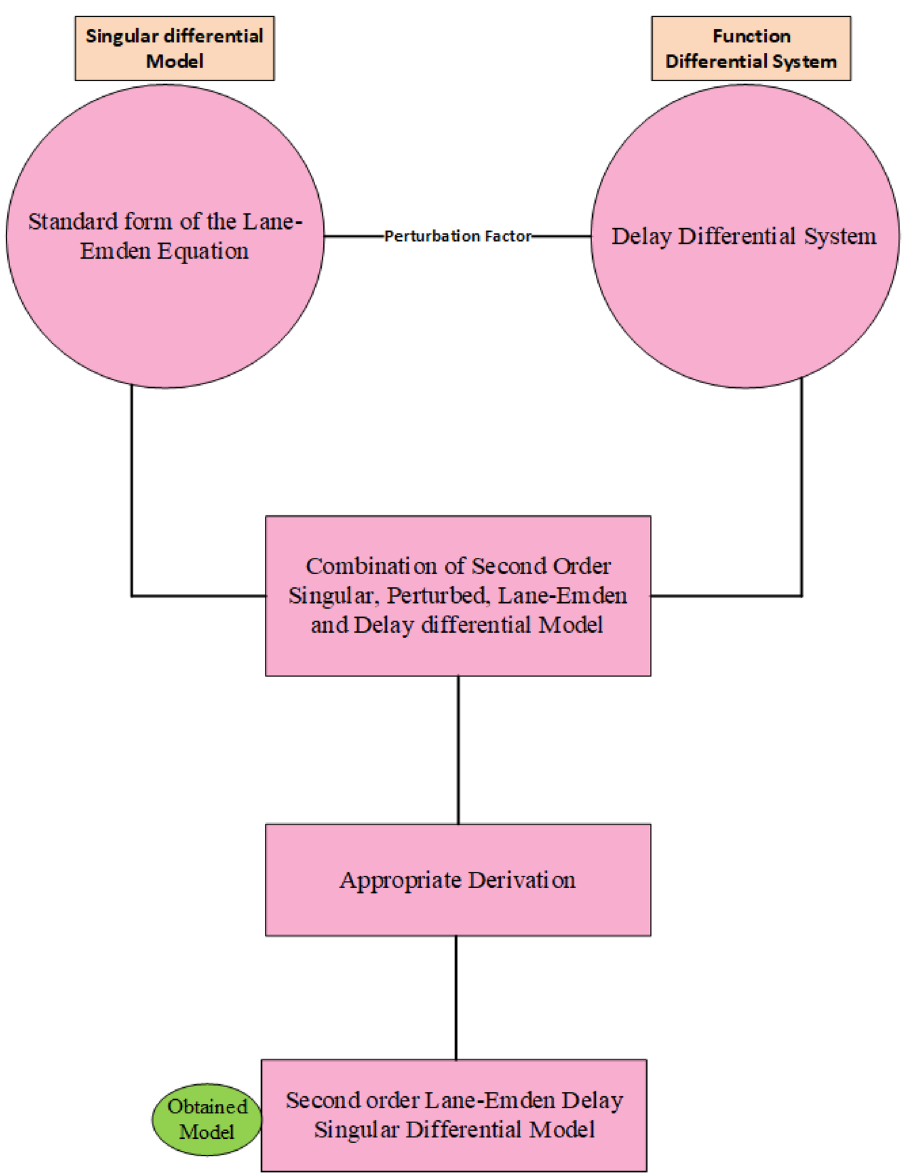
Figure 1. Description of Flow-chart for solving the novel